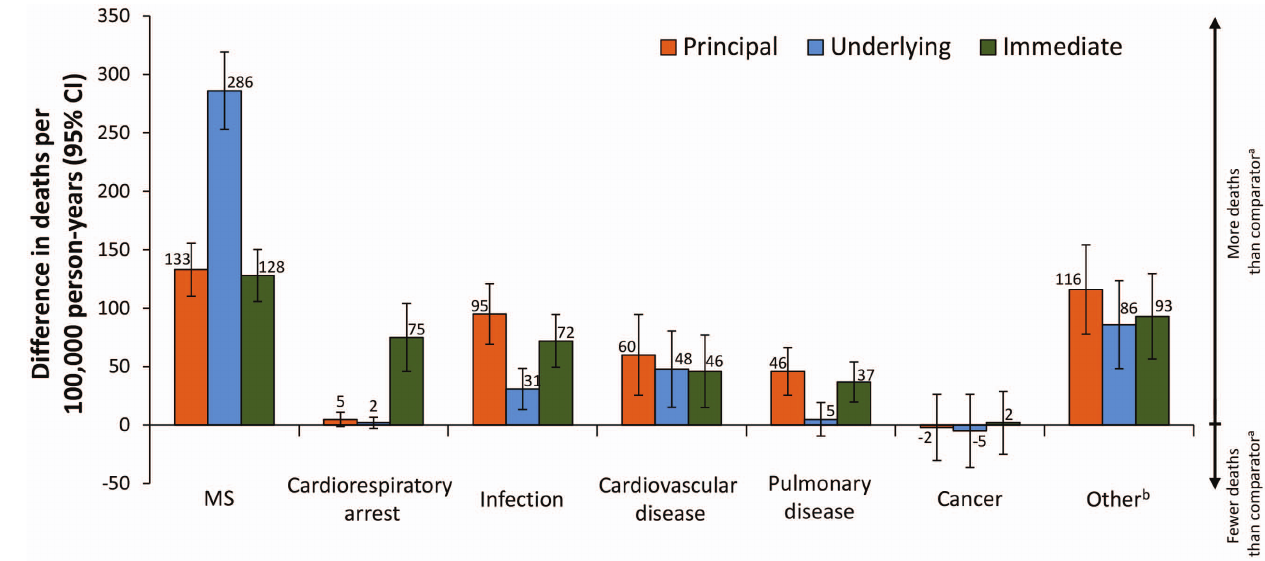
Figure 3. Difference in mortality rate (95% CI) between patients with MS relative to non-MS comparators by underlying, immediate, and principal COD. The difference in mortality rate between the MS and non-MS comparator cohorts using all 3 methods of determining COD. Positive values indicate disease/injury categories in which the MS cohort had a higher mortality rate. a Comparator was a non-MS population matched for age, sex, and residence region. One subject in the comparator group developed MS post-entry into the study. b Other includes suicide, accidental death, cancer, and those with an unknown COD.